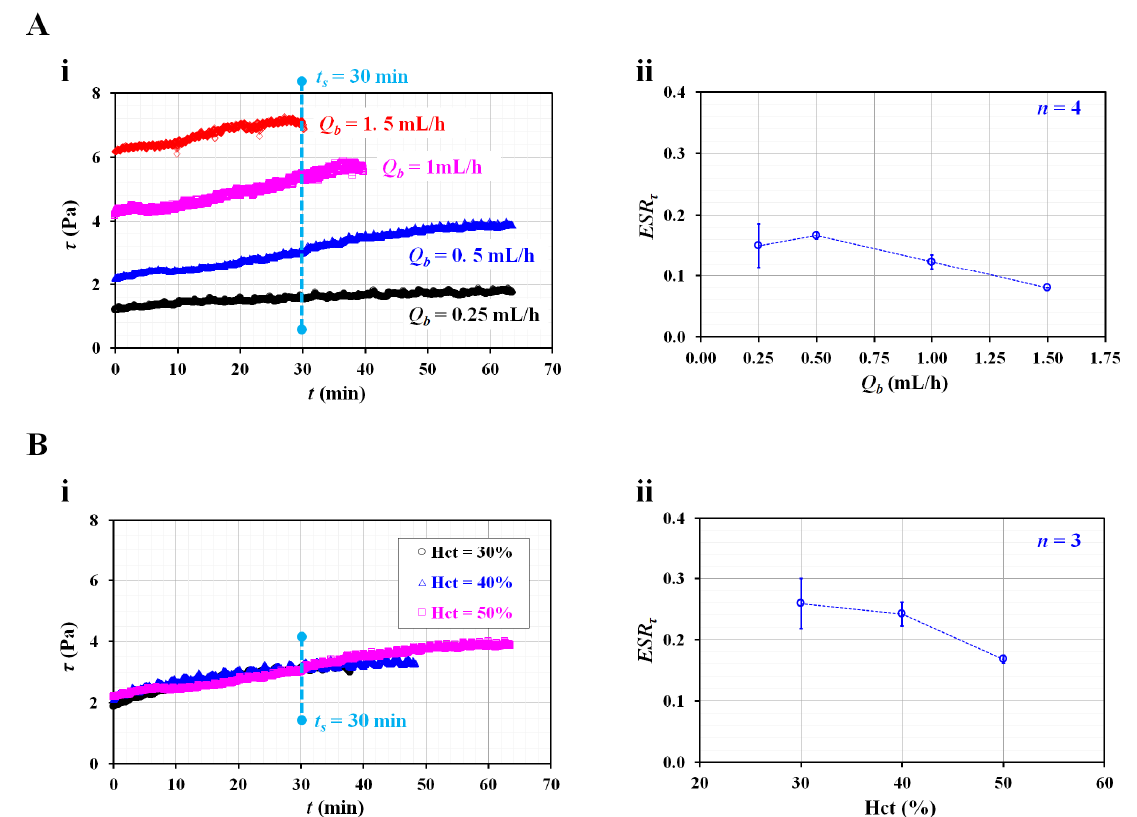
Figure 4. Contributions of flow rate and hematocrit to RBC sedimentation index ( ESR τ ). ( A ) Effect of blood flow rate on RBC sedimentation index. ( i ) Temporal variation of shear stress with respect to blood flow rate ( Q b ). ( ii ) Variation of ESR τ with respect to Q b . ( B ) Effect of hematocrit on RBC sedimentation index. ( i ) Temporal variation of shear stress with respect to Hct = 30%, 40%, and 50%. ( ii ) Variation of ESR τ with respect to